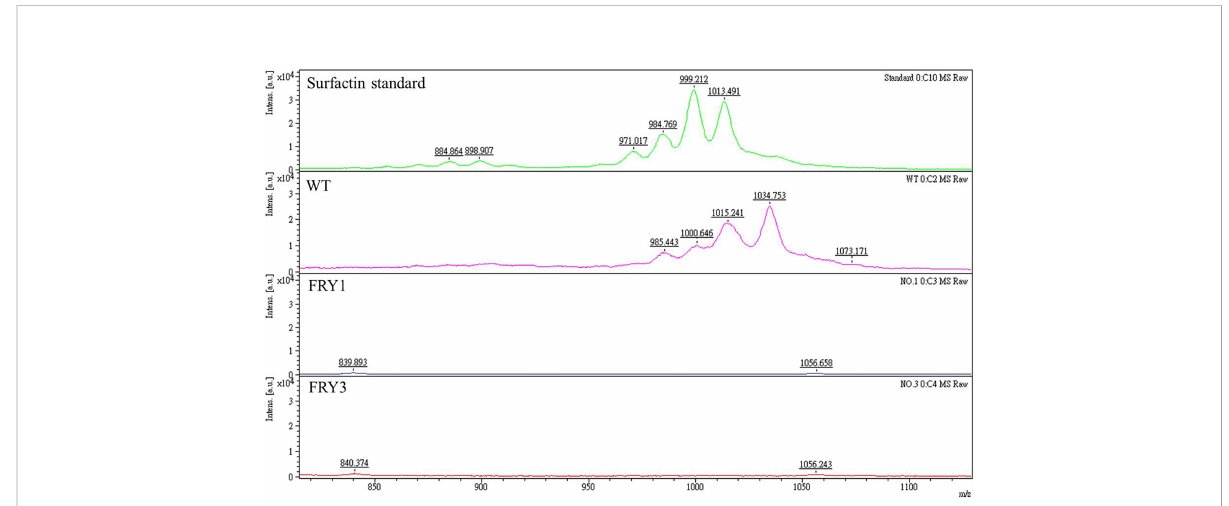
FIGURE 4 The D srf mutants lose the ability to secrete surfactins. The supernatants of cultures were collected and extracted twice with ethyl acetate, followed by resuspension with methanol before conducting mass spectrometry analysis. The surfactin peaks were found in the standard and wild type (WT), but de fi cient in D srf mutants (FRY1 and